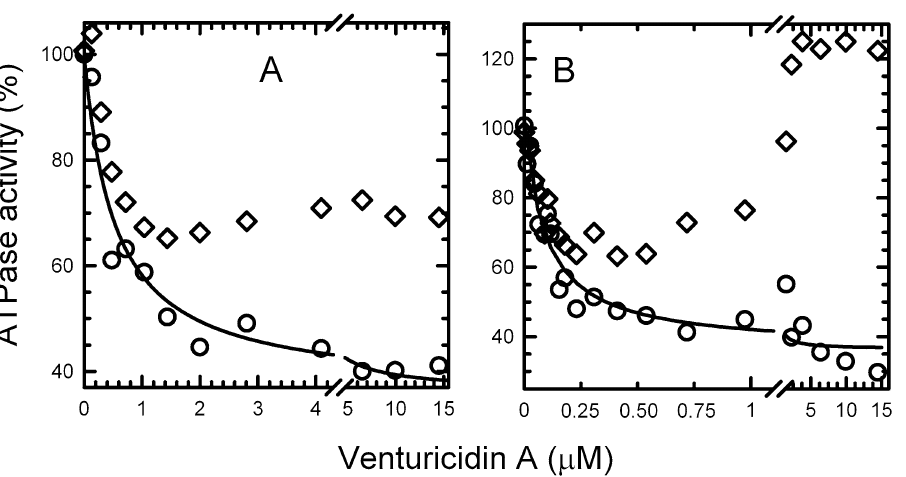
Figure 3. Concentration-dependence of venturicidin A’s effects on the ATPase rate of E. coli membranes with F O F 1 lacking the ε subunit’s CTD. The ε88-stop membranes were assayed for ATPase as in Fig. 1, but with 3.31 μg ( A ) or 0.93 μg ( B ) of membrane protein. As in Fig. 2, rates were measured ‘early’ ( ○ ) and ‘late’ (◊) after adding ventA in the absence ( A ) or presence of 38.5 mM selenite ( B ). Each line shows the best fit of all early rates ( ○ ) to the equation shown for Fig. 2. Activities corresponding to 100% and the best fit parameters for the lines are listed in Table